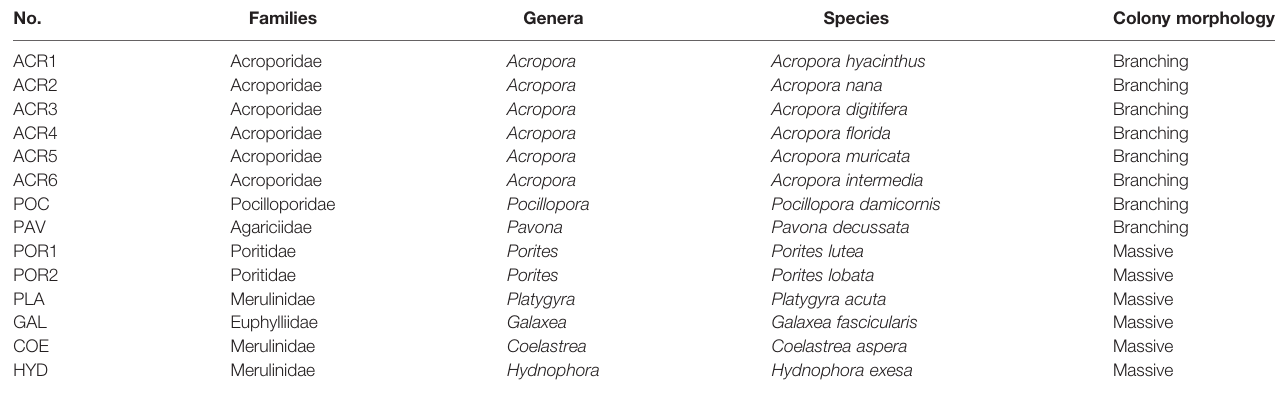
TABLE 1 | Families, genera, species, and colony morphology of the collected samples.